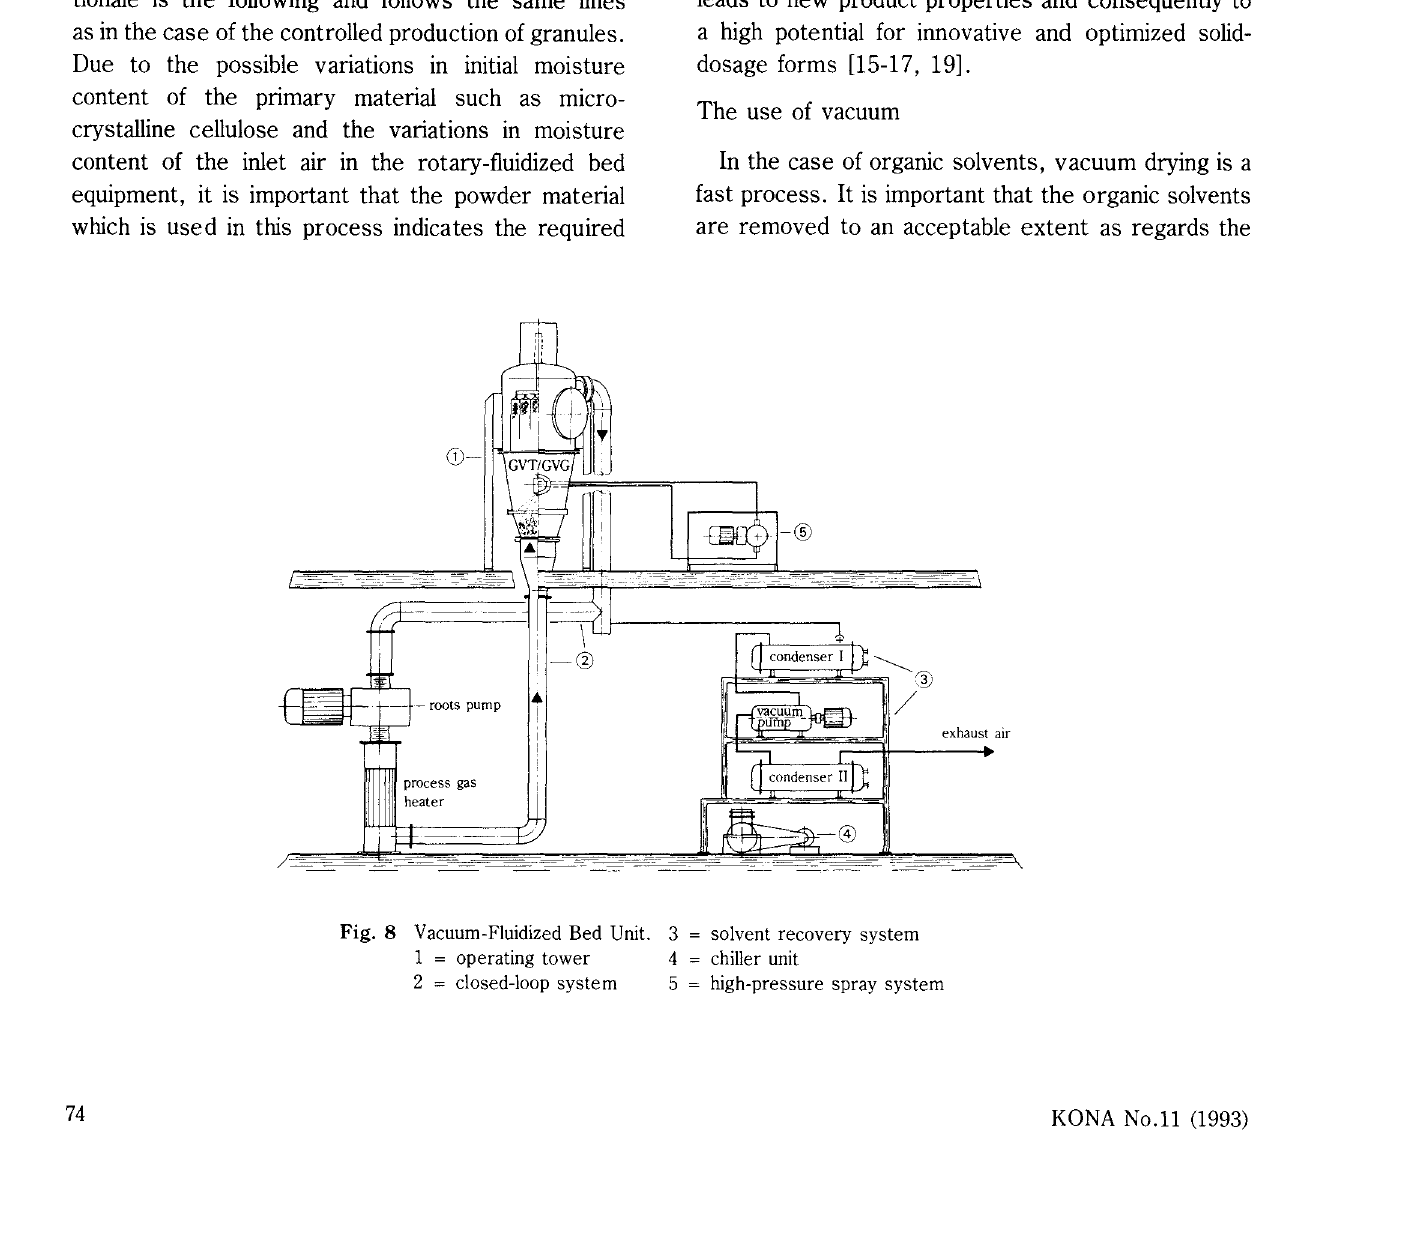
Fig. 7 Median pellet size as a function of the torque measured after stopping addition of granulating liquid. yield: between 710/Lm and 1000/Lm: 72%; between 710/Lm and 1400/Lm: 97%.